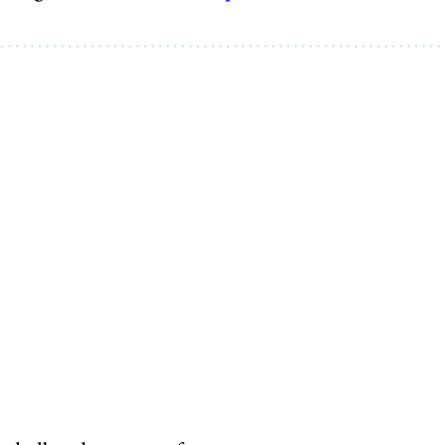
Figure 4. The maximum normal overlap distance of the shot ball and target